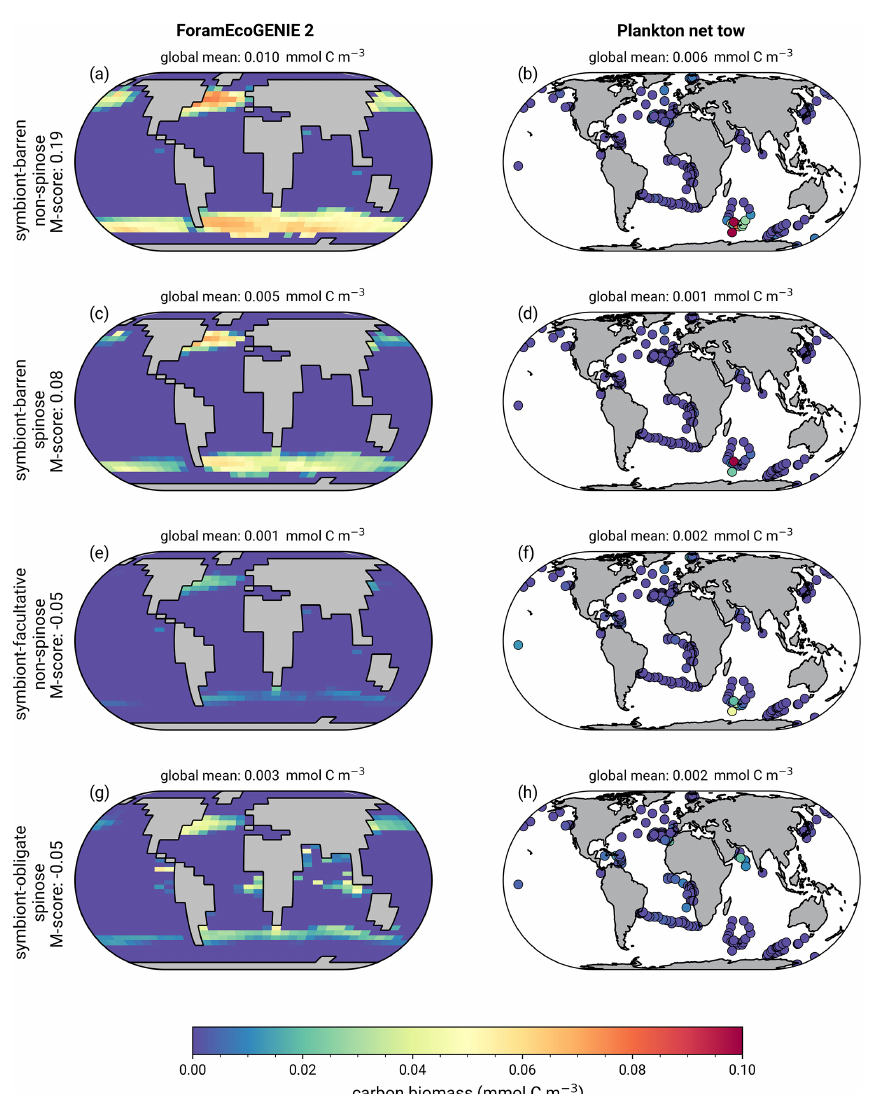
Figure 5. (a, c, e, g) ForamEcoGEnIE 2.0 annual average foraminiferal biomass (mmolCm − 3 ) compared with plankton net data (b, d, f, h) for the four main functional groups of planktic